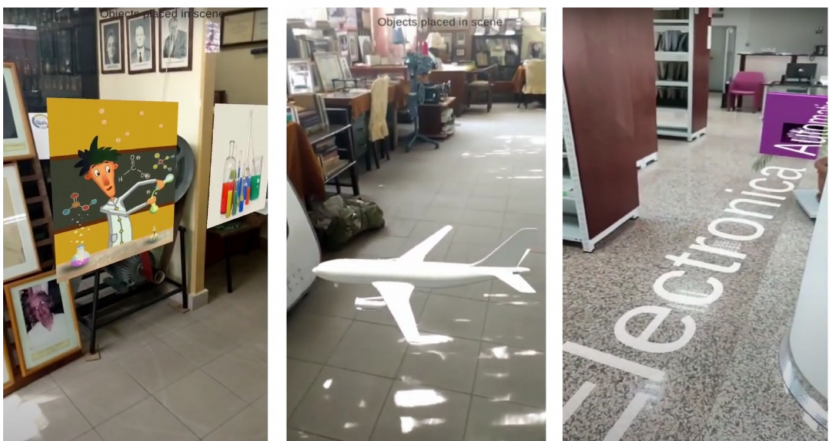
Figure 11. Piloting the computer vision-based localization: screen captures of the visitor’s phone, dis- playing two virtual images ( left ), a 3D model of a plane ( middle ), 3D text placed on the floor ( right